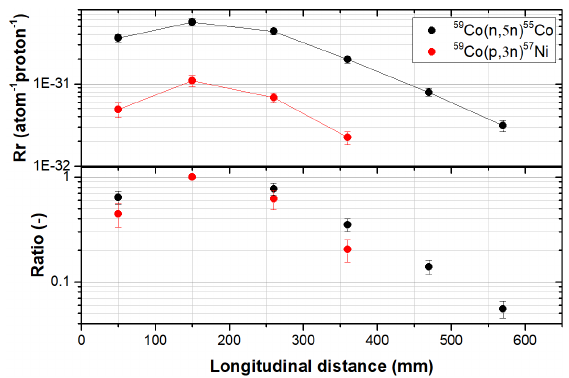
Figure 7. Determination and comparison of 59 Co ( n , 5 n ) 55 Co , and 59 Co ( p , n 3) 57 Ni reaction rates at lead